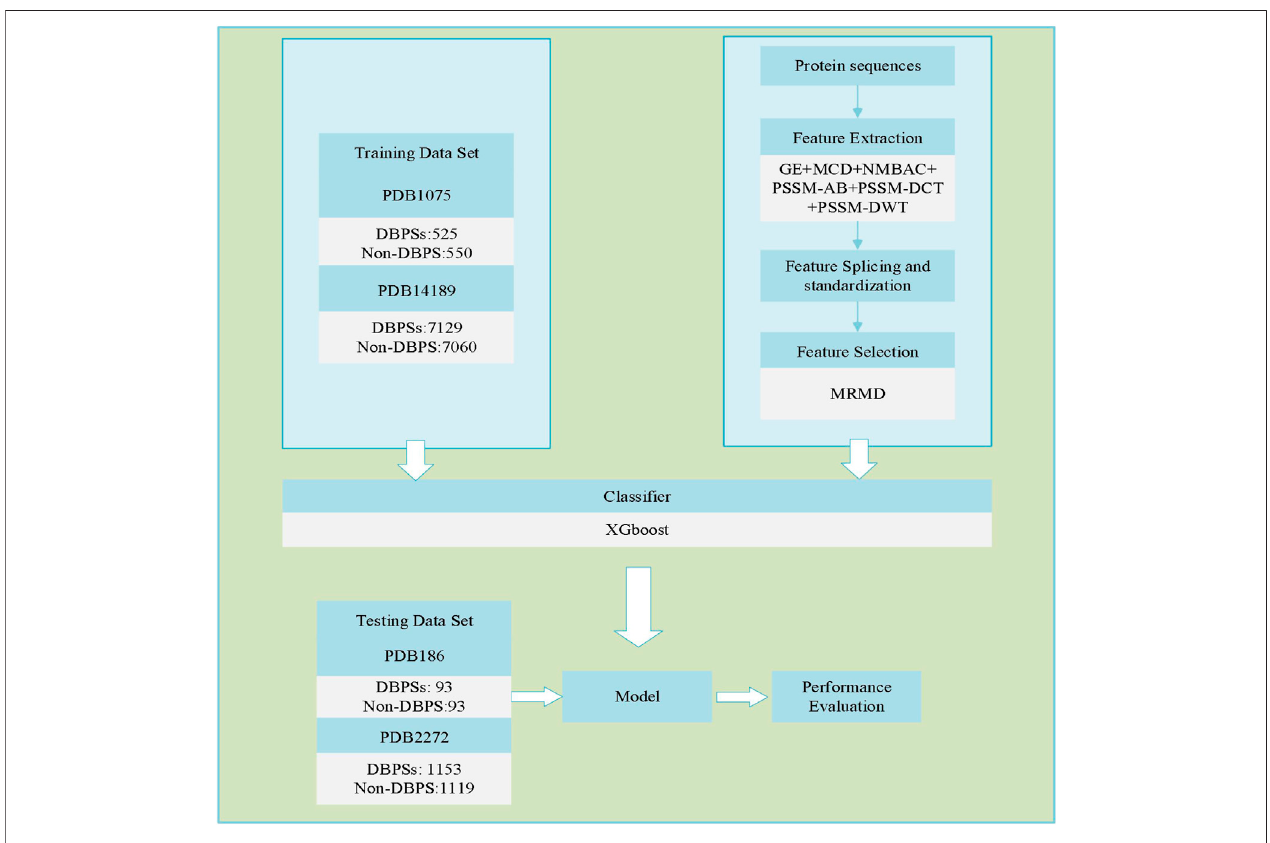
FIGURE 1 | Process of predicting DBPs.